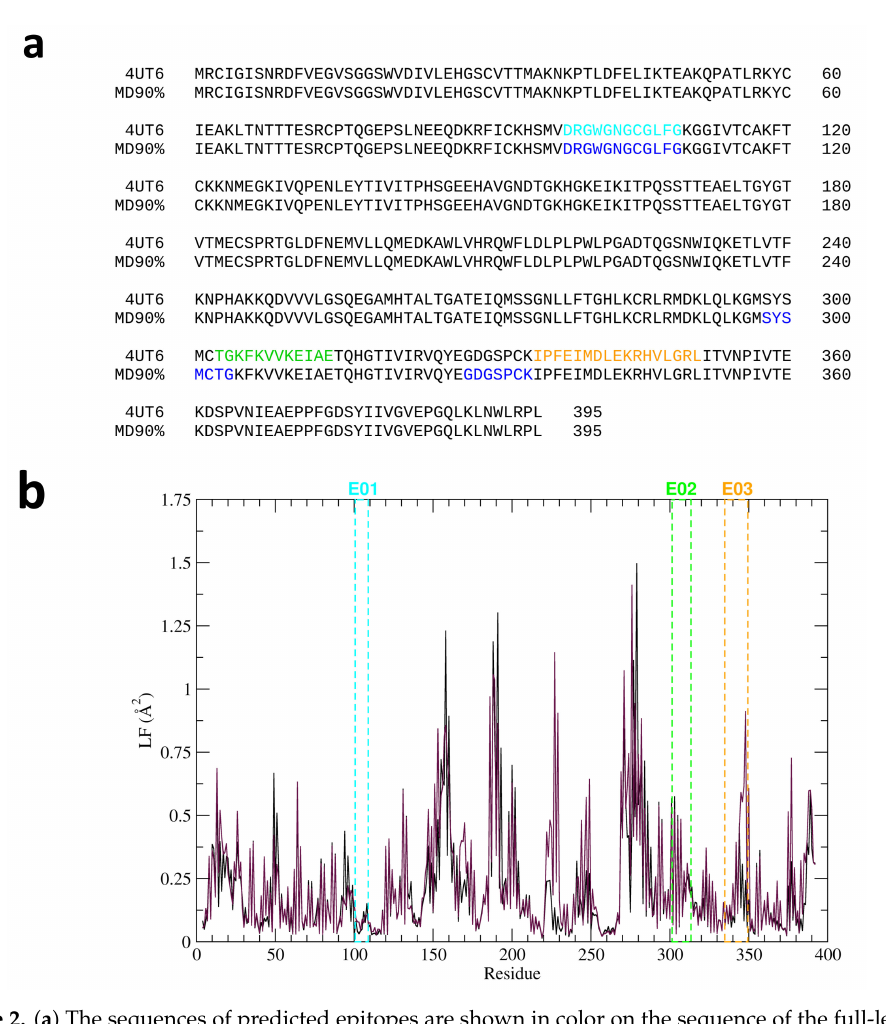
Figure 2. ( a ) The sequences of predicted epitopes are shown in color on the sequence of the full-length protein. The predictions on the crystal structure (line 4UT6) and on the cluster representative recapitulating 90% of the visited structures are shown. It is interesting to see that only E01, sequence DRGWGNGCGLFG, is predicted with no variation as an epitope in the two cases. ( b ) Local flexibility of each residue in each of the two monomers of the E protein. The predicted epitope regions are indicated with colored broken